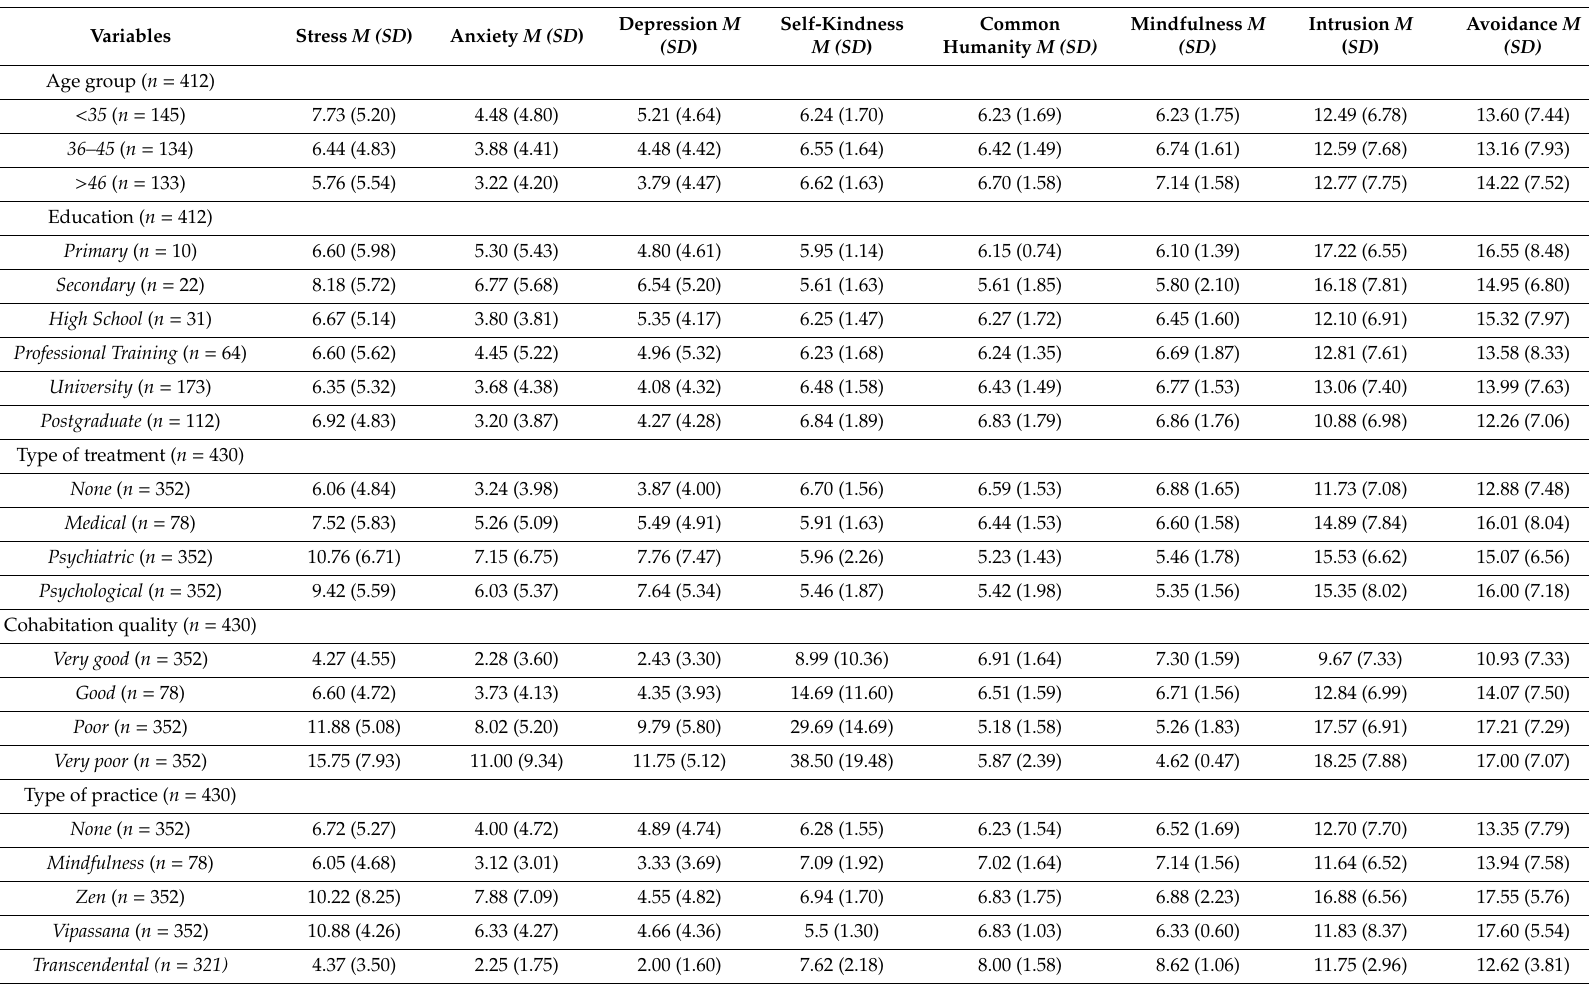
Table 2. Means and standard deviations of the Depression, Anxiety and Stress Scale-21 (DASS-21), Self-Compassion Scale (SCS), and Impact of Events Scale (IES) for sociodemographic